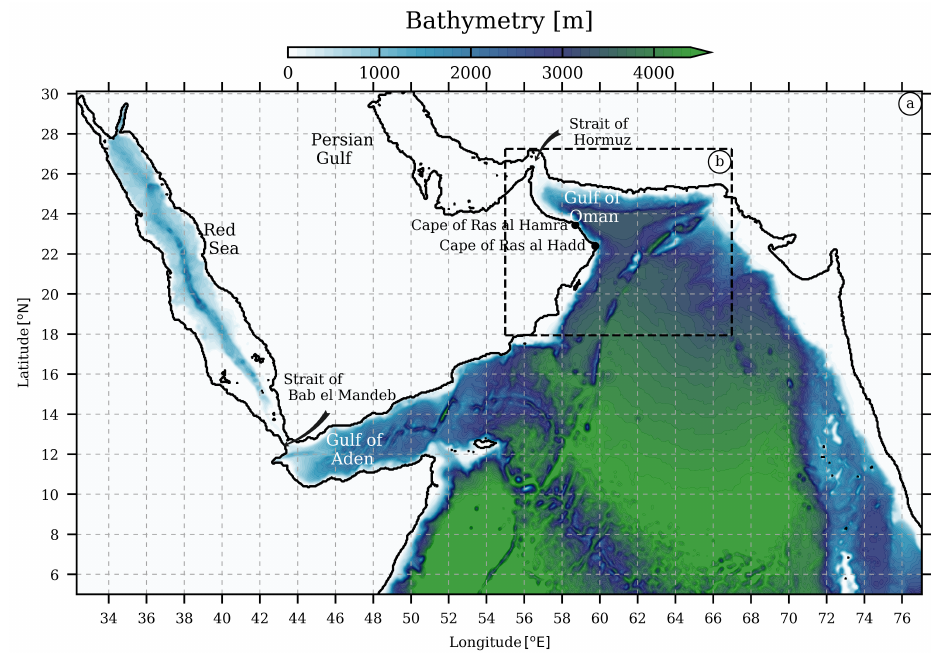
Figure 1. ( a ) Bathymetry of the Arabian Sea. ( b ) The domain used for the Agrif zoom is displayed in dashed black